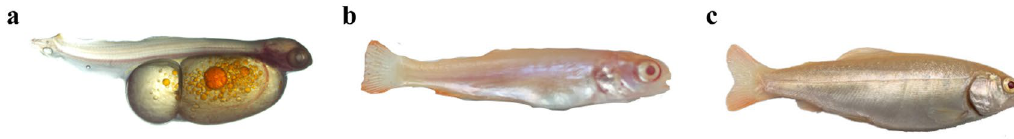
Figure 12. Three developmental stages of yellow mutant rainbow trout (YR). ( a ) 1 day post-hatching (YR1d). ( b ) YR45d. ( c )